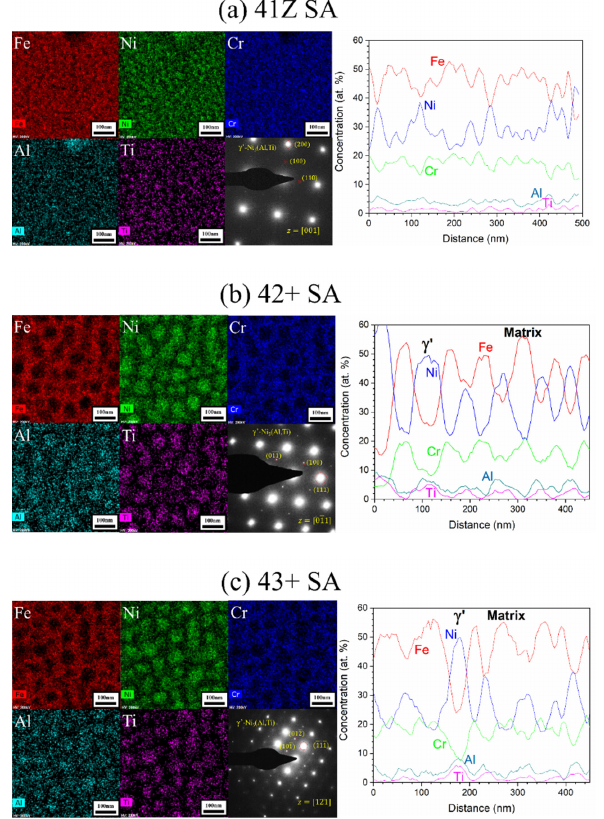
Figure 11. STEM-EDS mapping and line scan analysis results with SAD pattern for the alloys ( a ) 41Z SA, ( b ) 42+ SA, and ( c ) 43+ SA after the creep test in air at 750 °C and 150 MPa.